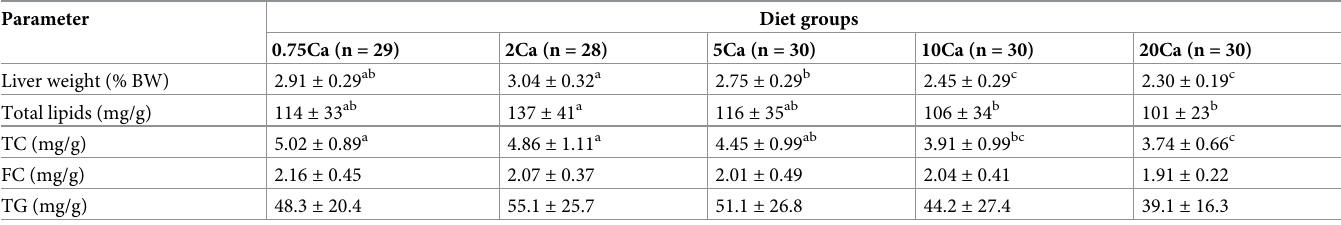
Table 3. Liver weight and lipid